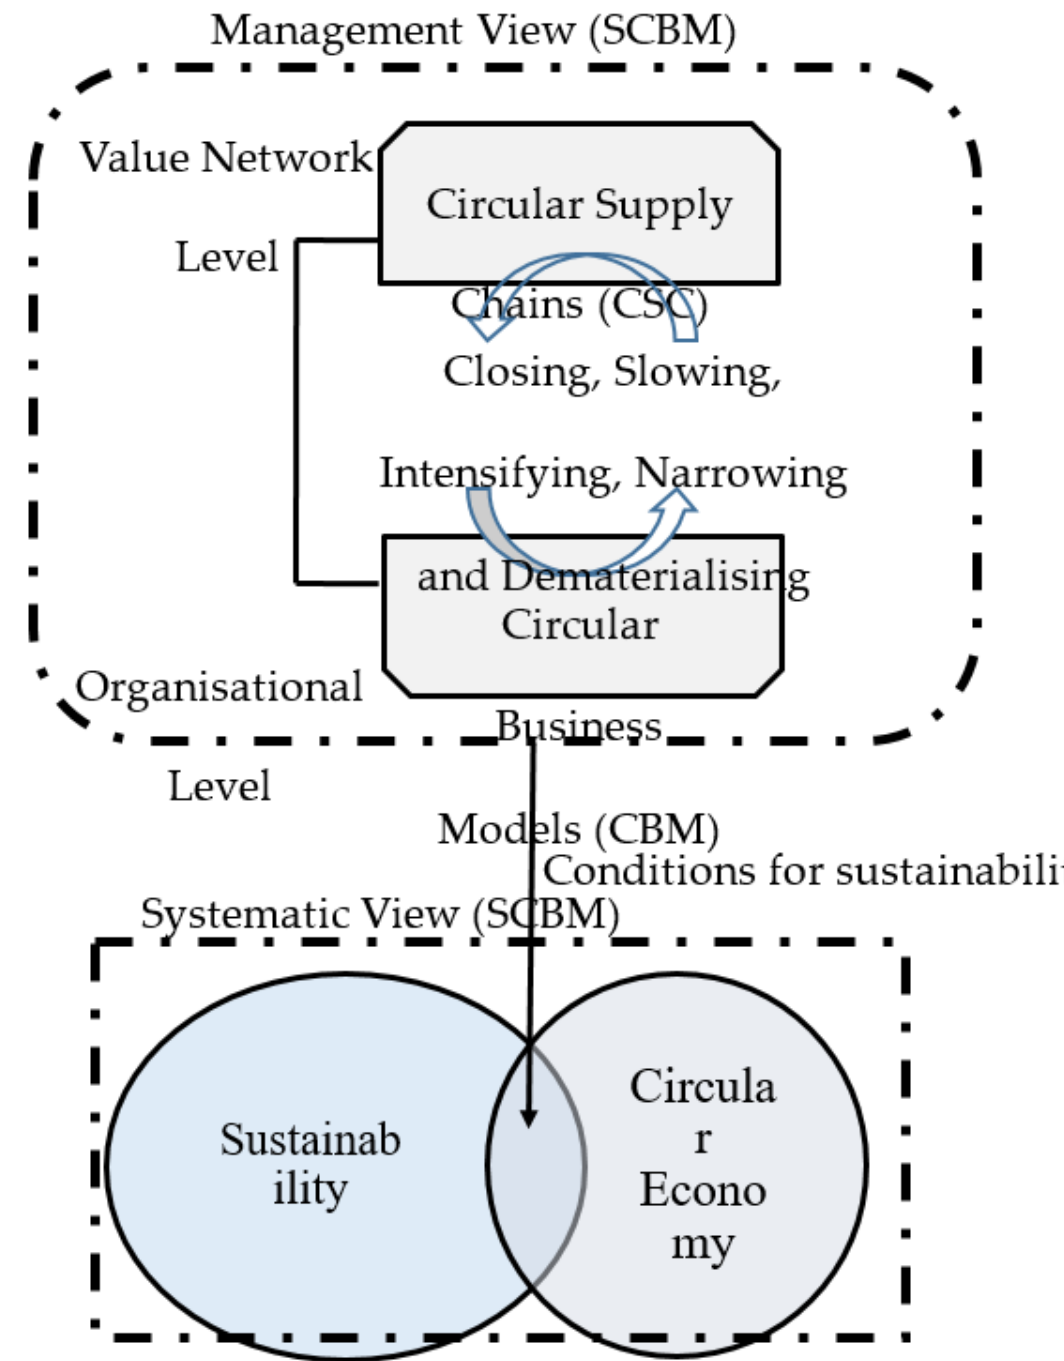
Figure 5. Proposed SCBM framework.